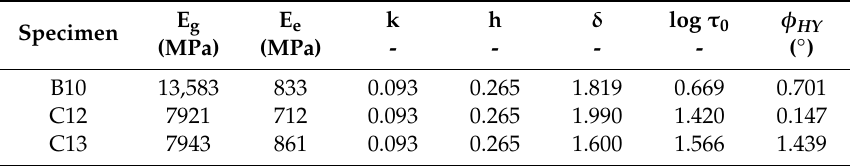
Figure 15. Master curves of CRAM at 20 °C: ( a ) stiffness modulus E 0 ; ( b ) phase angle ϕ .